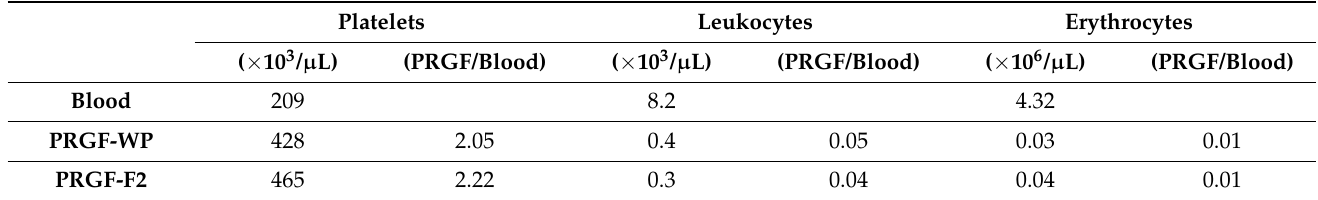
Table 1. Haematological characterization of PRGF plasma preparations. Ratio PRGF/blood means number of platelets in PRGF versus number of platelets in peripherical blood.